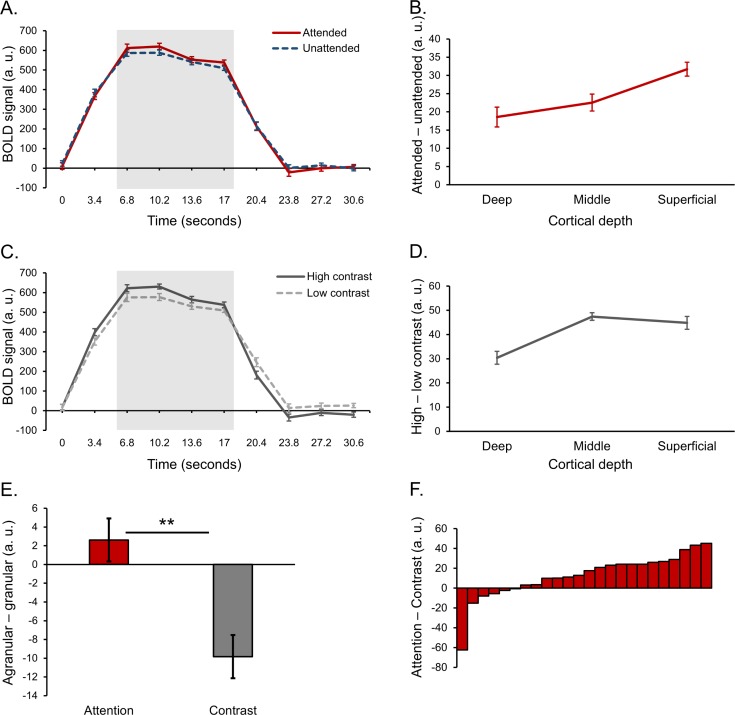
Main results using raw layer-specific time courses with no normalization.Our main results (shown in Figure 2) were obtained using layer-specific time courses that were normalized by z scoring data within layers. It was possible that normalizing in this manner could have impacted our effect sizes of interest. This is because the standard deviation across a time course, the denominator in a z score calculation, is somewhat dependent on the size of response fluctuations caused by our manipulations of attention and contrast. To determine whether this was the case, we repeated all the analyses from Figure 2 of raw layer-specific time courses without any normalization. The figure shows that both the attention (panel A) and contrast (panel C) effect sizes appear very similar to those in Figure 2, indicating that any effect of within-layer z scoring on effect sizes was negligible. Layer-specific effects (panel B, D–F) are also highly similar to those reported in our main analysis in Figure 2. All error bars depict within-subjects standard error.